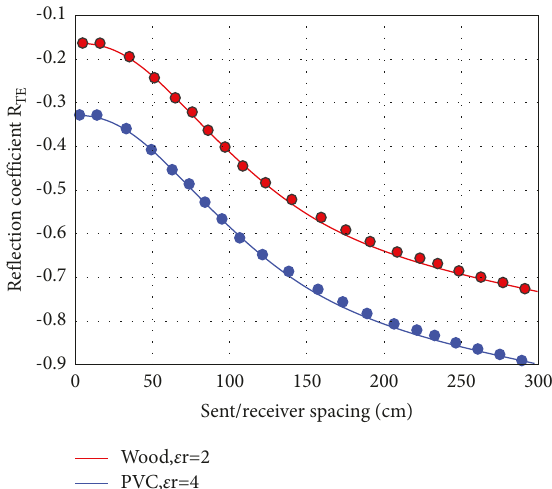
Figure 3: Reflection coefficient of electromechanical control signal under horizontal polarization.